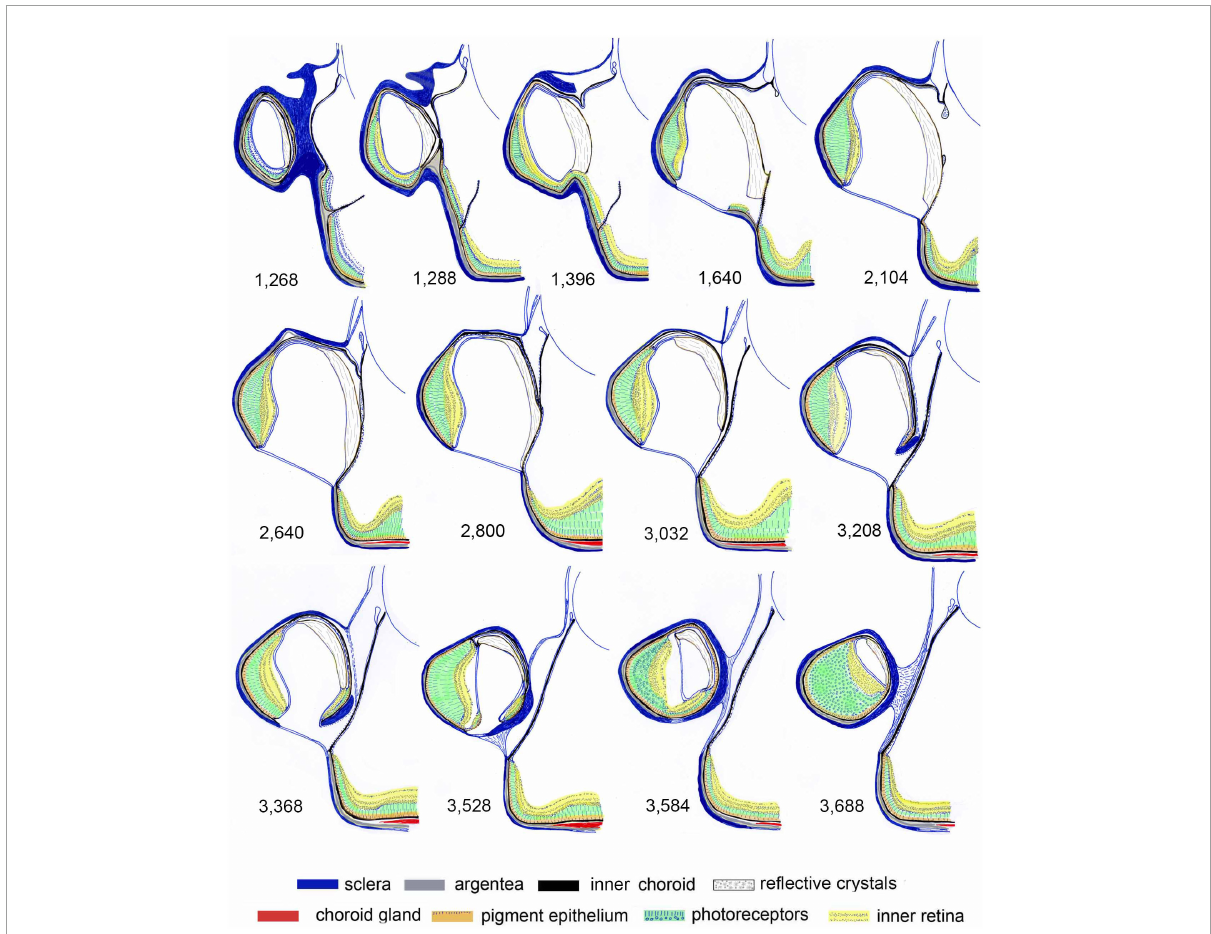
FIGURE4 Schematic representation of serial sections through the diverticulum of Dolichopteryx longipes . 2 µ m transverse sections were cut starting rostrally at a spacing of 4 µ m through the diverticulum of a large animal (SL 102 mm). The numbers indicate the distance in µ m from the rostral edge of the